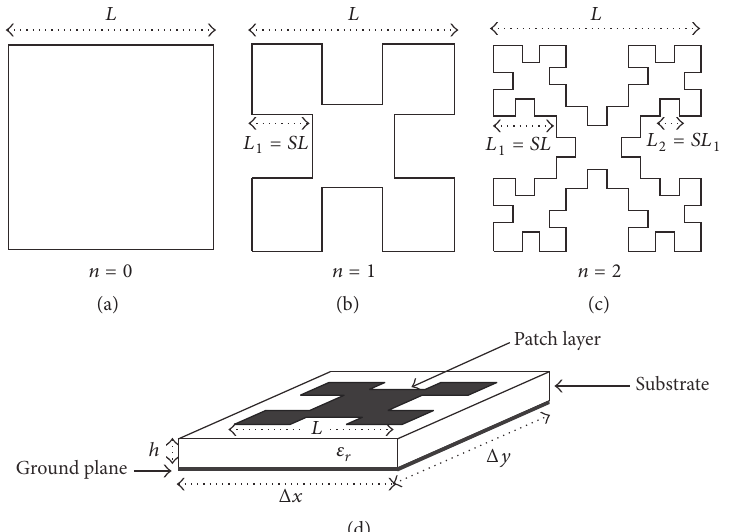
Figure 6: Minkowski fractal geometry: (a) generator square patch; (b) first iteration patch; (c) second iteration patch; and (d) unit cell layers.